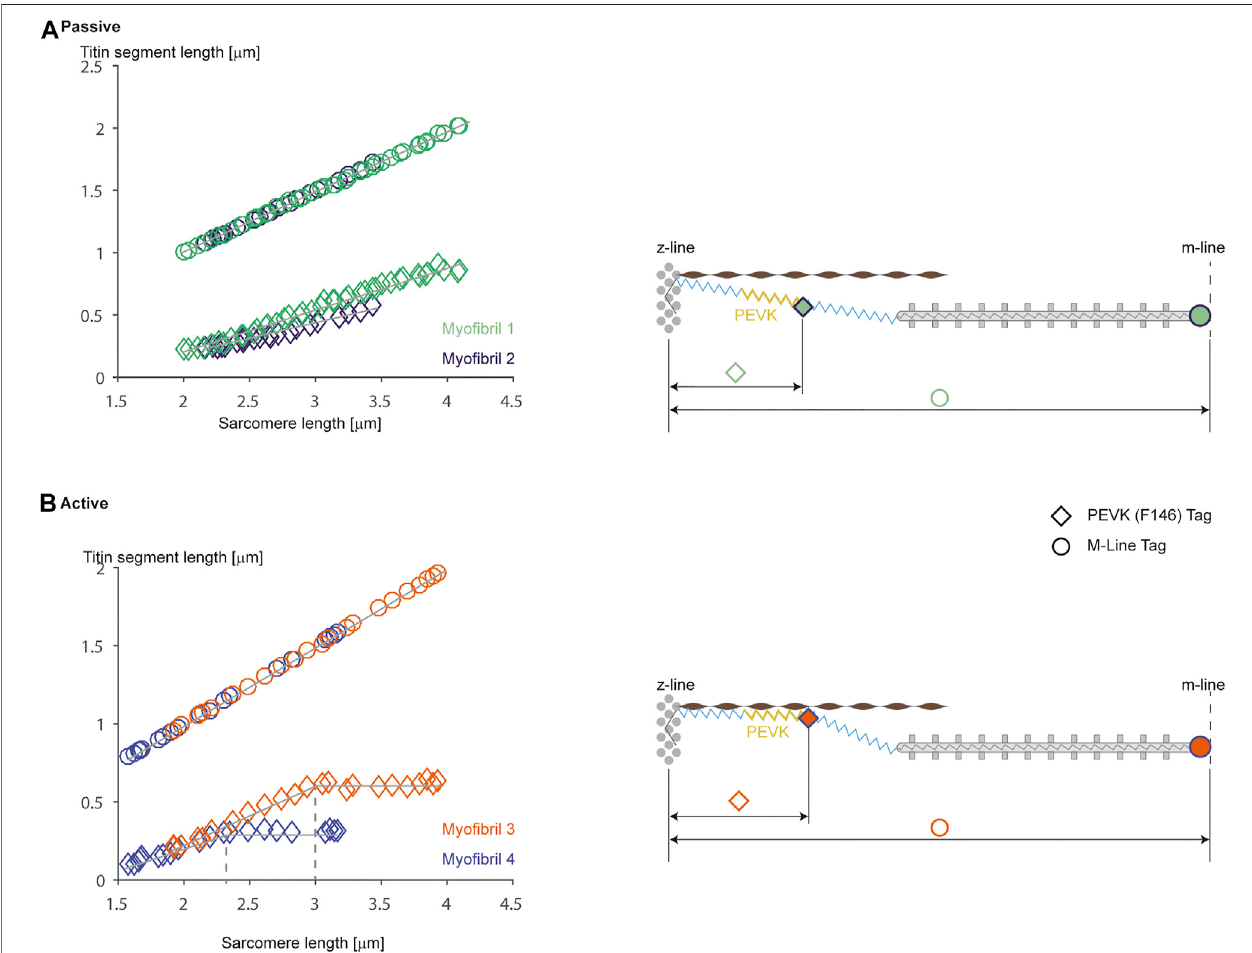
FIGURE 6 | Passive (A) and active (B) stretching of proximal titin segments labeled using an antibody [F146 that binds to the PEVK region (diamond symbols)] region that allows for measurements of proximal and distal titin segment elongations during passive and active stretching of single rabbit psoas sarcomeres. Figures on the left show elongation of the half-sarcomere [top traces (circular symbols) using an M-line label] and elongations of the proximal titin segment (bottom traces: from the Z-line to the F146 label) for two representative sarcomeres from two different myo fi brils. Note in (A) (passive stretching) that the two proximal titin segments elongate continuously with half-sarcomere elongations, reaching fi nal lengths of approximately 0.95 μ m (at a sarcomere length of 4.0 μ m) and about 0.6 μ m (at a sarcomerelengthofabout3.5 μ m).Incontrast,whenthemyo fi brilsarestretchedwhileactivated,theproximalsegmentselongatesimilarlytotheelongationsobservedin the passive condition, but then stop elongating and remain substantially shorter than in the passive case (i.e., with a length of about 0.6 and 0.35 μ m, respectively). The panels on the right illustrate schematically what we believe might be happening. In the passive stretch (A) , the proximal and distal titin segments elongate in accordance with their stiffness properties. In the active stretch (B) , titin is thought to attach to actin at some point during the stretch, thereby shortening titin ’ s free spring length, increasing its stiffness, eliminating elongation of the proximal titin segment, and increasing titin-based force. Republished with permission of American Physiological Society, from Residual force enhancement following eccentric contractions: a new mechanism involving titin. Herzog W., Schappacher Tilp G, DuVall M, Leonard TR, Herzog J. Physiology 31: 300 – 312. 2016; permission conveyed through Copyright Clearance Center